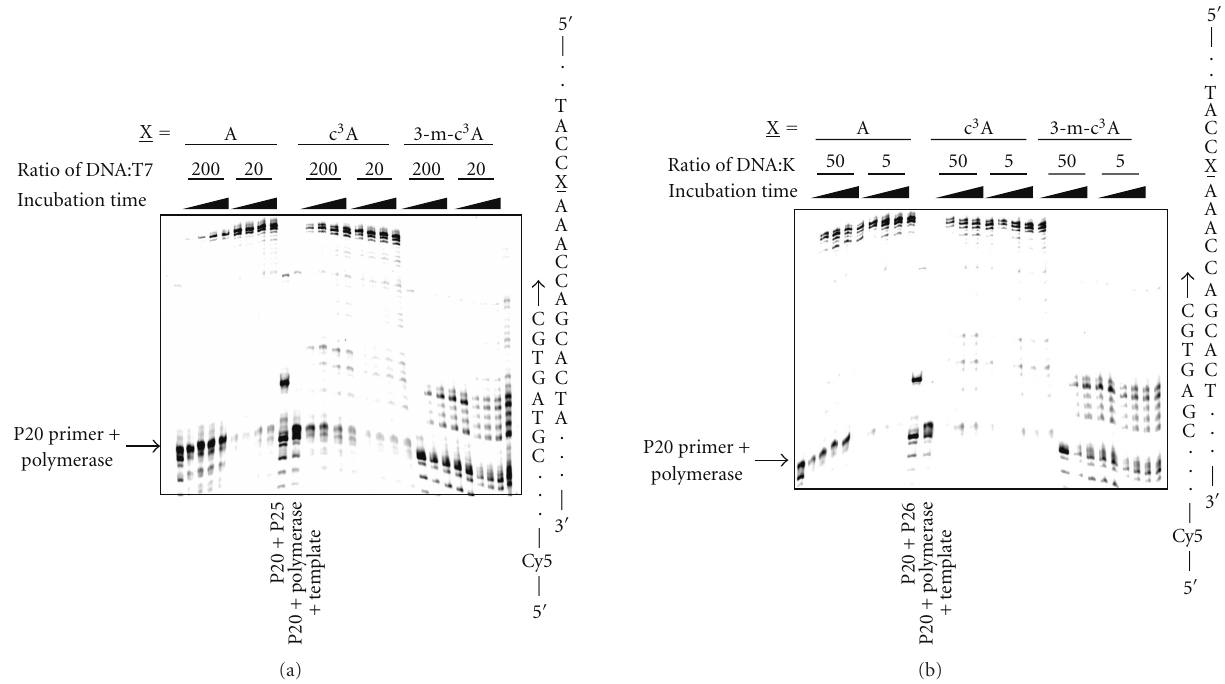
Figure 6: The e ff ect of 3-deazaadenine (c 3 A) and 3-methyl-3-deazaadenine (3-m-c 3 A) lesions on (a) T7 Sequenase and (b) Klenow fragment polymerization. The template strand with an A, c 3 A or 3-m-c 3 A at position-27 (X) was incubated for 2.5, 5, 10 or 20 minutes with polymerase at 37 ◦ C using DNA to enzyme ratios of 200:1 or 20:1 for T7 Sequenase, and 50 :1 or 5:1 for Klenow fragment (exo − ), respectively. Lanes with primer-20 + polymerase + template, and primers-20 and -25 (no polymerase or template) are included as markers. There is evidence for bands indicating stalling of polymerization with the c 3 A and a quantitative block with 3-m-c 3 A, which is also reflected in the extended